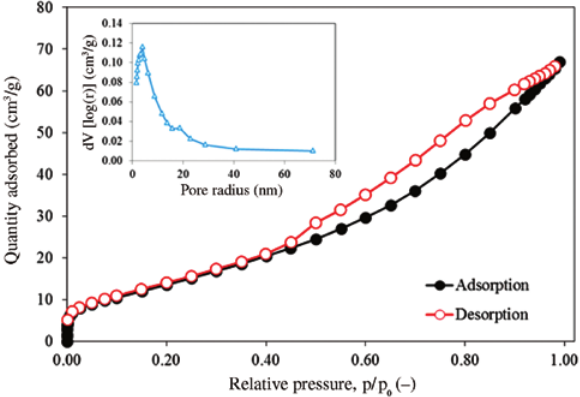
adsorption-desorption isotherm at (77 K) pore Figure 8: The N 2 size distribution (inset) of the phytogenic magnetic nanoparticles